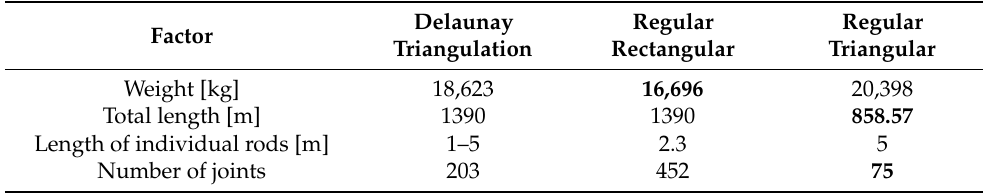
Table 3. A comparison of chosen fabrication factors of Delaunay, regular triangular, and quadrilateral grid divisions (authors